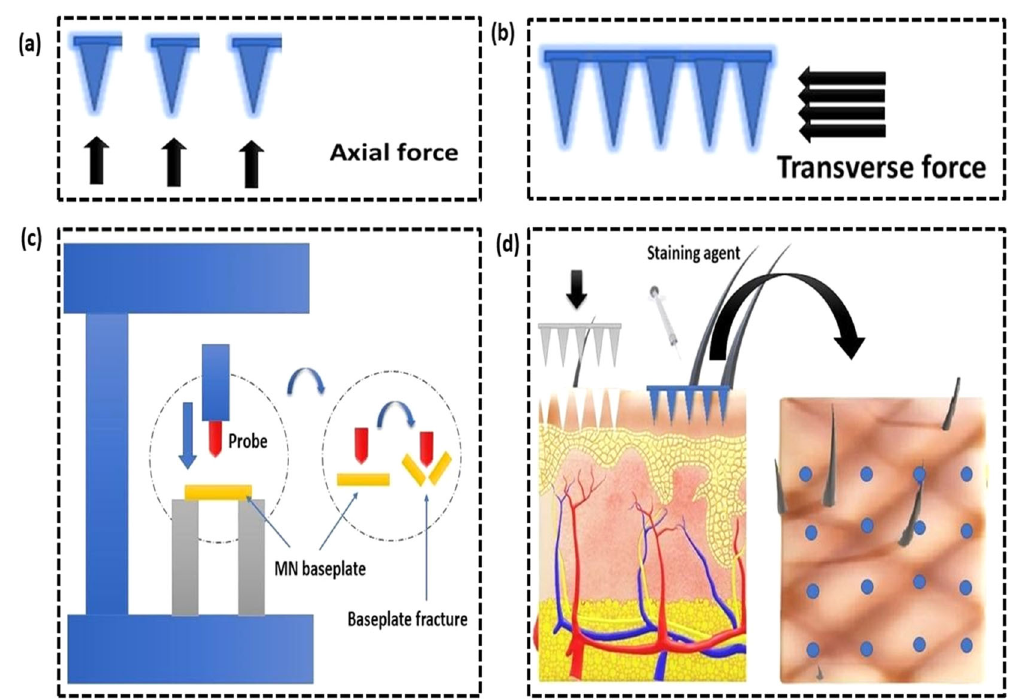
Fig. 6 Illustration of the mechanical properties of MNs. a Axial force test. b Transverse force test. c Base-plate strength and fl exibility tests. d Microneedle-insertion measurement by staining